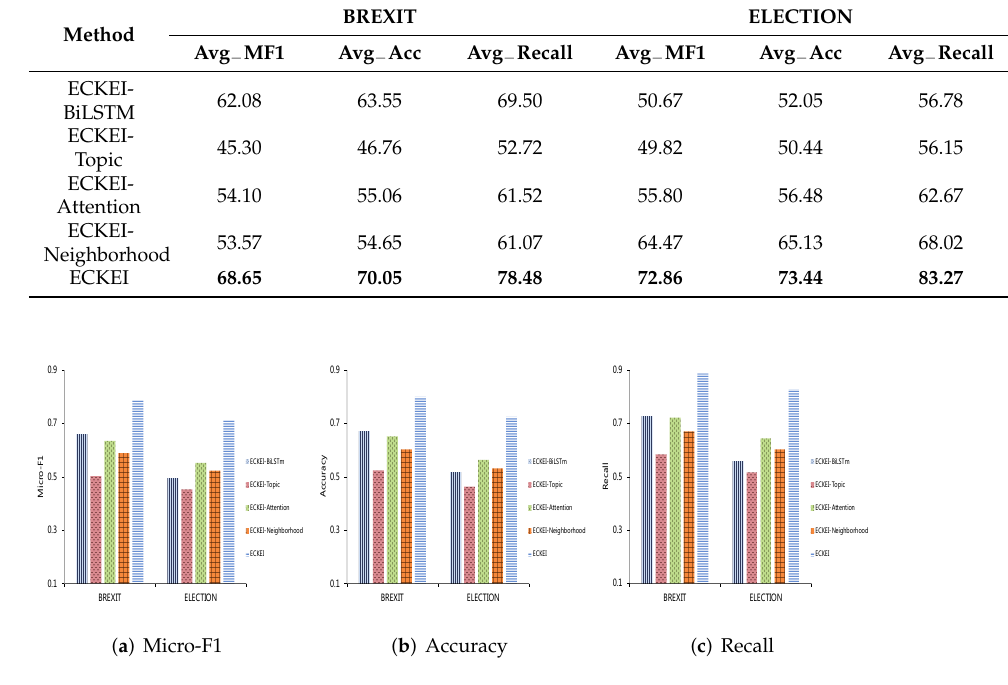
Figure 10. Micro-F1, accuracy and recall ablation results on two datasets for the support